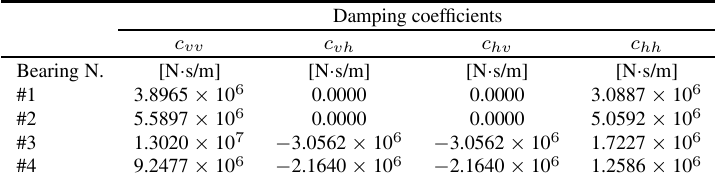
Table 4 Oil- fi lm damping coef fi cients of bearings from #1 to #4, evaluated at 3000 rpm